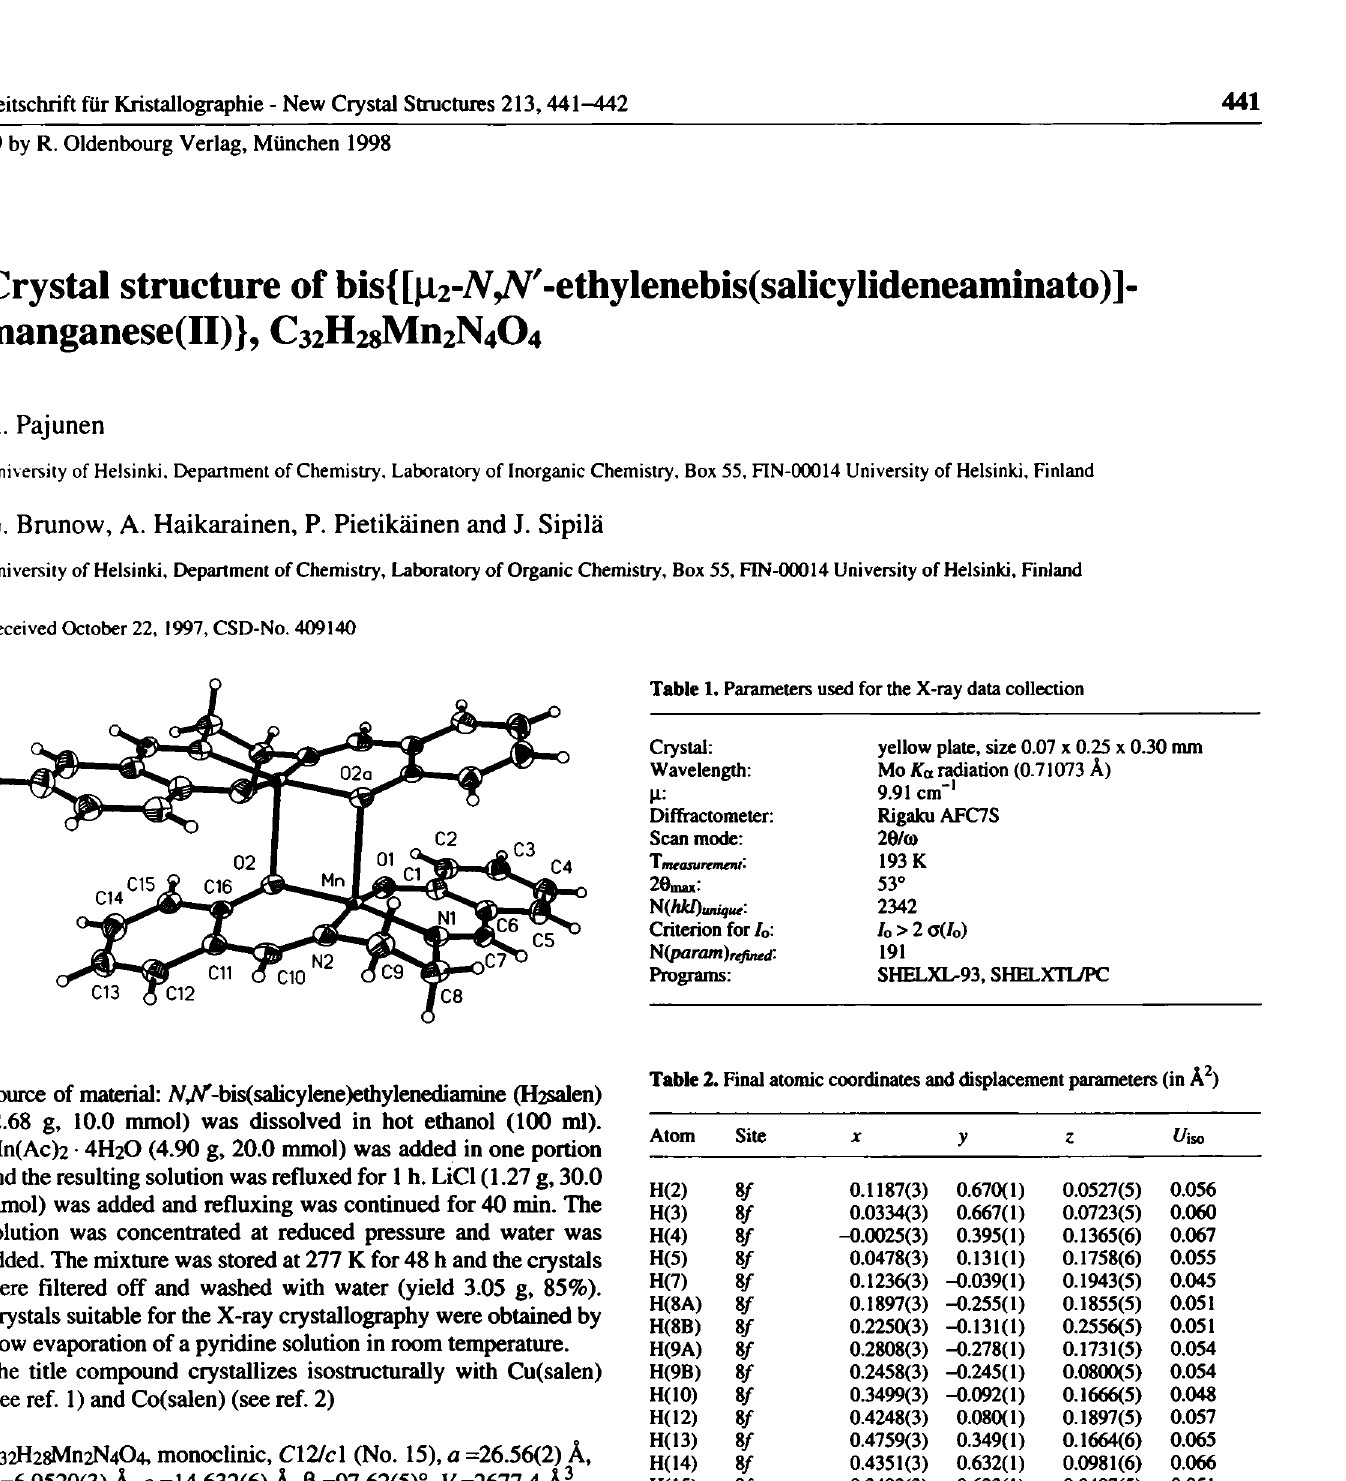
Table 3. Final atomic coordinates and displacement parameters (in À^)